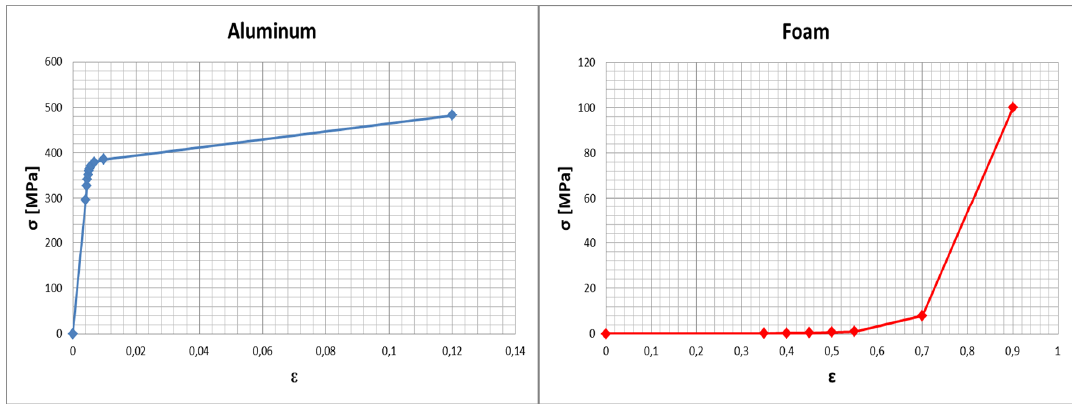
Figure 5. Sigma-epsilon curves.